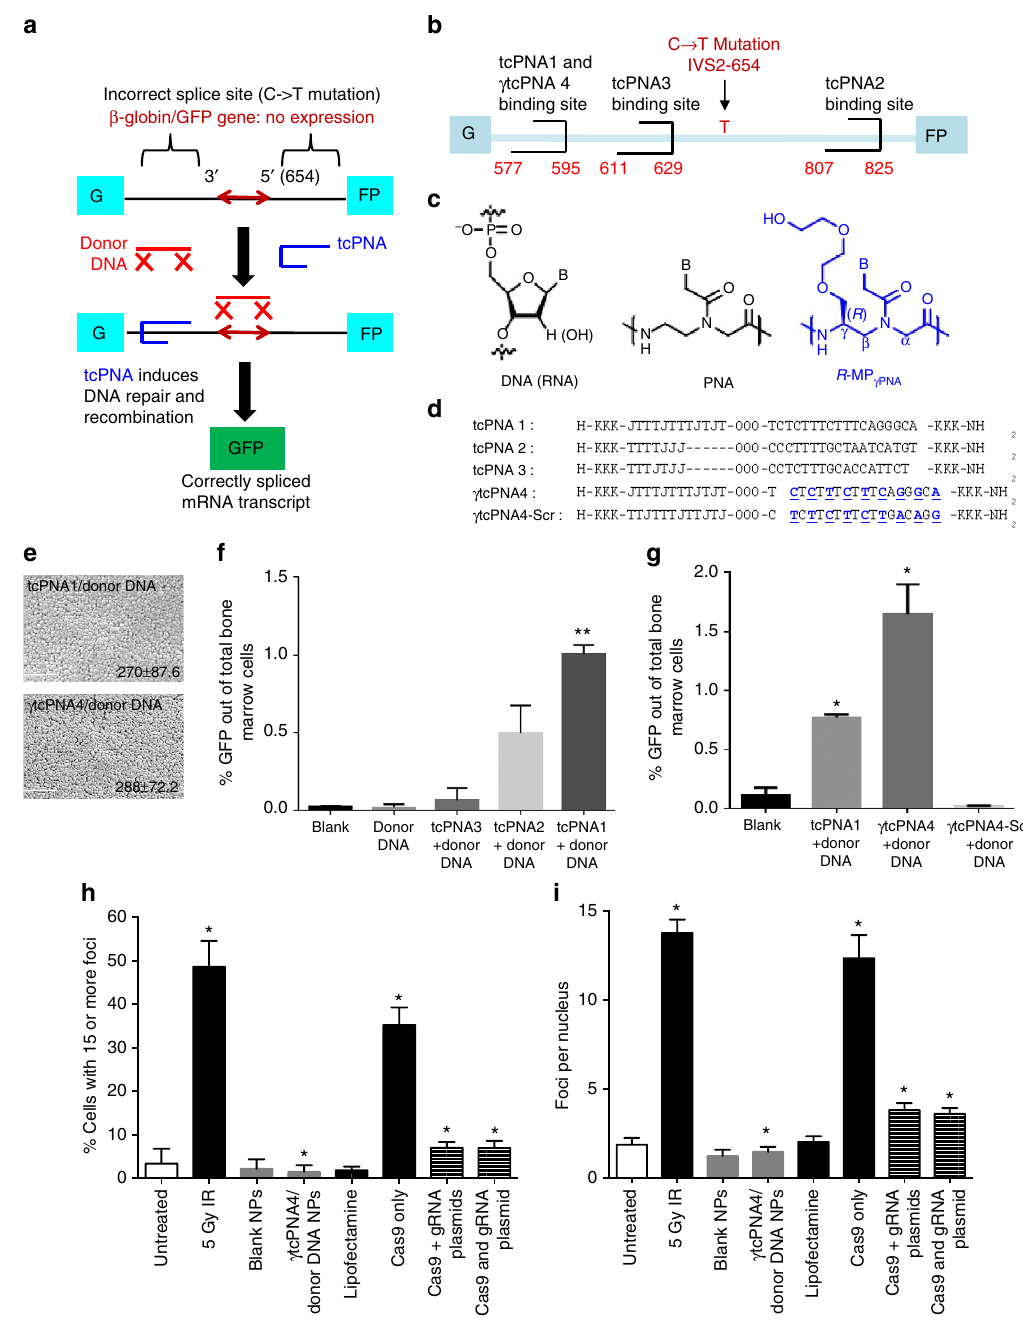
Figure 1 | Gene editing using c PNAs in mouse bone marrow. ( a ) Strategy for targeted correction of a b -globin gene IVS2-654 (C- 4 T) mutation in b -globin/GFP transgenic mice using triplex-forming tail-clamp PNAs and donor DNAs. ( b ) tcPNA and g tcPNAs designed to bind to homopurine regions within intron 2 of the human b -globin gene near IVS2-654 (C- 4 T). ( c ) DNA, unmodified PNA and MP g PNA. ( d ) tcPNAs and g tcPNAs to bind to the positions indicated in B. g tcPNA4-Scr is a scrambled version of g tcPNA4. Bold/underline indicates g PNA residues. K indicates lysine; J, pseudoisocytosine (for c ) for pH-independent triplex formation. O, 8-amino-2,6,10-trioxaoctanoic acid linkers connecting the Hoogsteen and Watson–Crick domains of the tcPNAs. ( e ) Scanning electron microscope images of nanoparticles. Scale bar, 2.0 m m. ( f ) Gene correction of the IVS2-654 (C- 4 T) mutation within the b (cid:2) globin/GFP fusion gene in mouse BM cells treated ex vivo with NPs containing the indicated tcPNAs and donor DNA. %GFP þ was determined by flow cytometry and indicates successful gene editing. Data are mean ± s.e., n ¼ 3; statistical analysis by Student’s t -test, ** P o 0.005. ( g ) %GFP þ cells in mouse BM after ex vivo treatment with NPs containing tcPNA1, g tcPNA4 or g tcPNA4-Scr, plus donor DNAs. Data are mean ± s.e.m., n ¼ 3; analysis by Student’s t -test, * P o 0.05. ( h , i ) Quantification of g H2AX foci by immune fluorescence microscopy, indicative of DNA DSBs in primary fibroblasts (from the b -globin/GFP transgenic mice) either untreated or treated with 5 Gy of IR, blank NPs, NPs containing g tcPNA4 and donor DNA, lipofectamine alone, lipofectamine transfection of a Cas9 expression vector, lipofectamine transfection of a Cas9 vector and a separate guide RNA expression vector (targeting the same site in b -globin sequences as g tcPNA4; Cas9 þ gRNA), or transfection of a vector containing both Cas9 and guide RNA (Cas9 and gRNA). Quantification as per cent of cells with 15 or more foci ( h ) or average number of foci per cell ( i ). 100 cells were counted per condition, data are mean ± s.e.m, n ¼ 3; analysis by Student’s t -test, * P o 0.05. NATURE COMMUNICATIONS|7:13304|DOI: